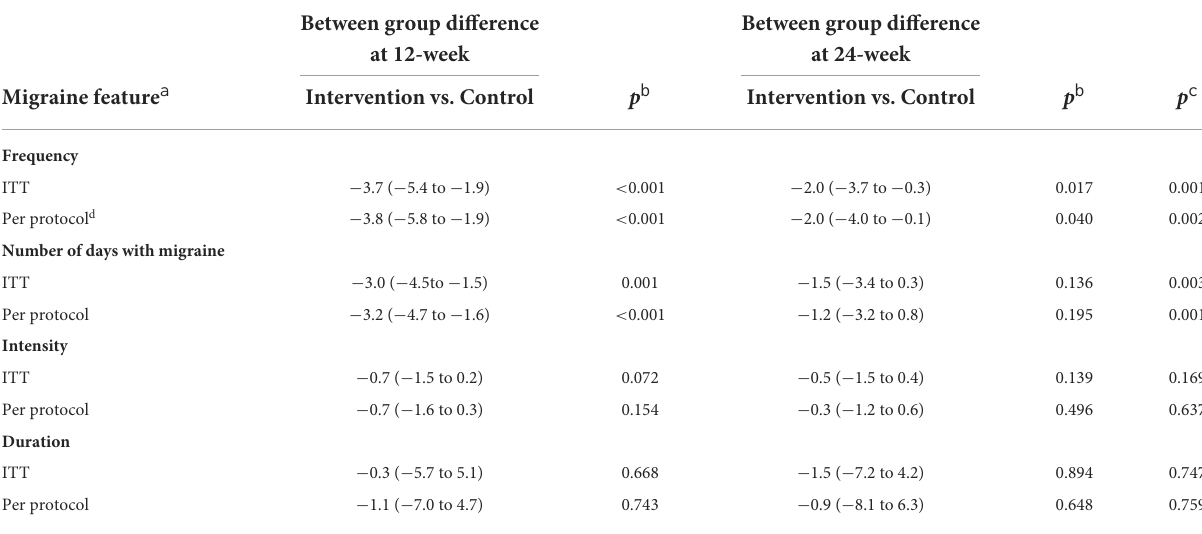
TABLE 3 Between-group differences of migraine features at 12-week and 24-week. Between group difference Between group difference at 12-week at